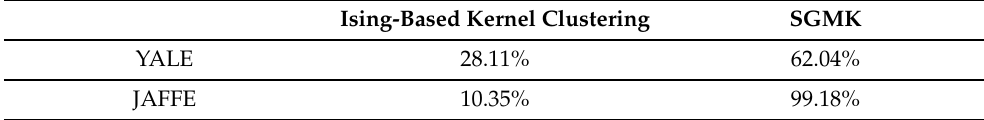
Figure 17. The NMI of Ising-based kernel clustering for YALE and JAFFE datasets. Table 2. The comparison of NMI between the Ising-based kernel clustering and